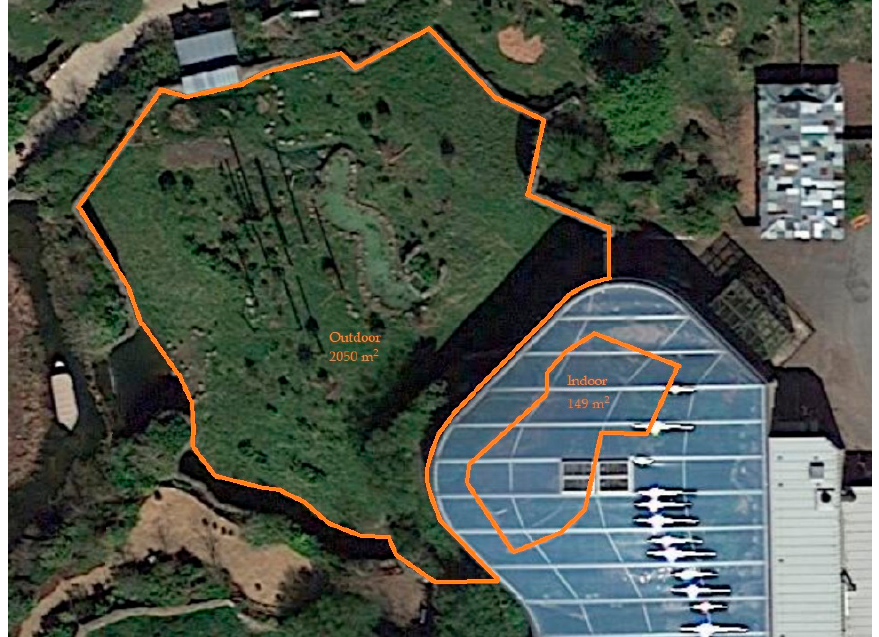
Figure A4. Enclosure plan for Sulawesi crested macaques ( Macaca nigra ) in Monsoon Forest in the Islands exhibit. Orange lines signify approximate areas accessed by individual animals with dimensions of total available space. Copyright: Google Earth.